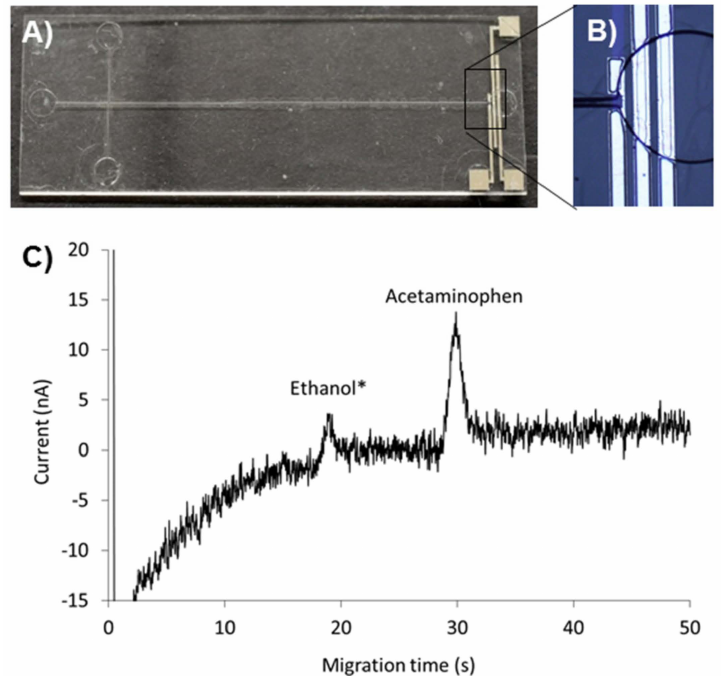
Figure 5. ( A ) Photograph of the Ormocomp electrophoresis separation chip featuring ( B ) Pt electrodes for on-chip amperometric detection. ( C ) Electrophreogram of 20 µ M acetaminophen in 20 mM 2-( N -Morpholino)ethanesulfonic acid (MES) (pH = 6.5) bu ff er. The electric field strength during the electrophoresis separation was 290 V / cm and the working electrode potential 0.8 V. ( * ) The ethanol peak is due to the residual solvent (0.2% ethanol) originating from the acetaminophen stock